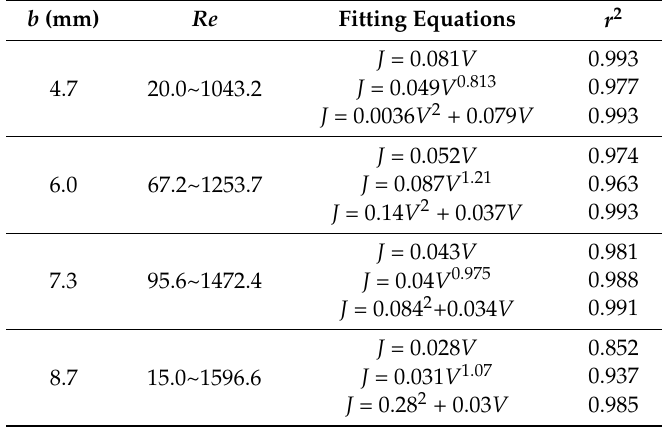
Table 4. Fitting results and goodness of fit for the V – J relationship for flow through single fractures with rectangular roughness.